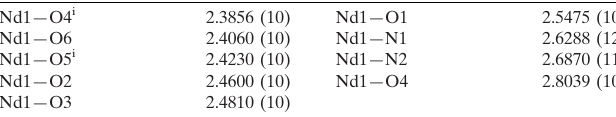
Selected bond lengths (A˚